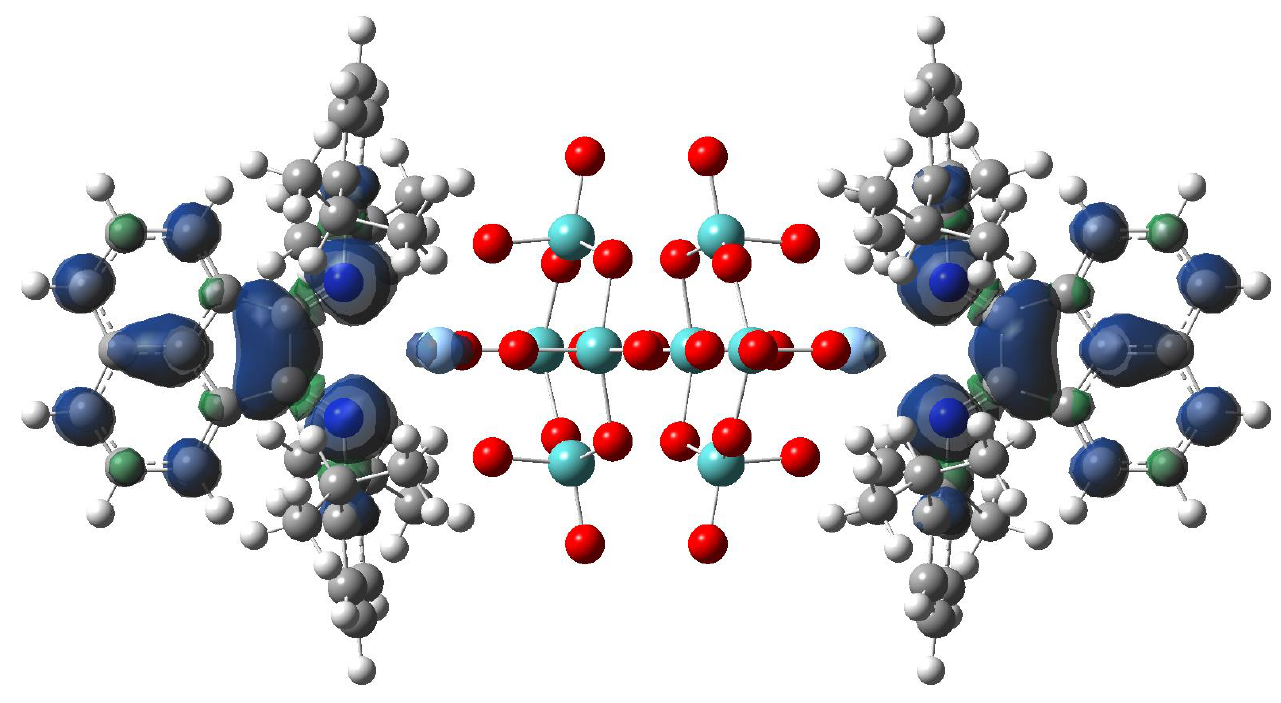
Figure 9. The spin density distribution on [{Ag(dpp-bian)} 2 Mo 8 O 26 ] 3 •− anion. According to the calculated data, for the first reduced state (induced during electro- reduction) the spin density was mostly located over two BIAN ligands. Moreover, its small portion affects both Ag atoms. Thus, we can conclude that electron transfer to CO 2 can be indeed realized from the combination of Ag and BIAN electronic states.